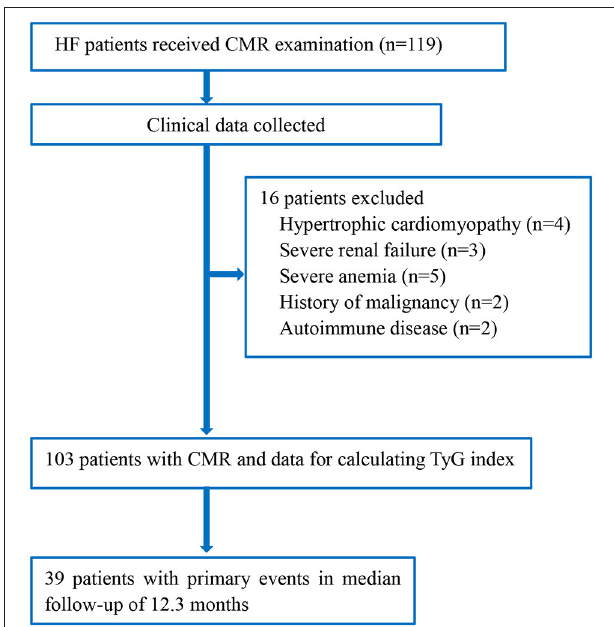
FIGURE 1 | Flowchart of the study. CMR, cardiac magnetic resonance; HF, heart failure; TyG index, triglyceride–glucose index.